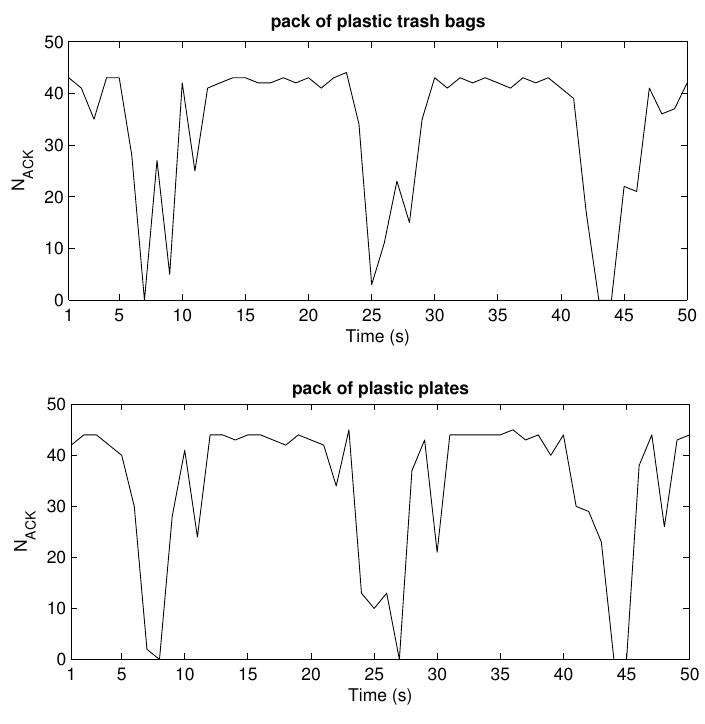
Figure 17. Sniffer measurements of tag responses when attached on plastic products of similar